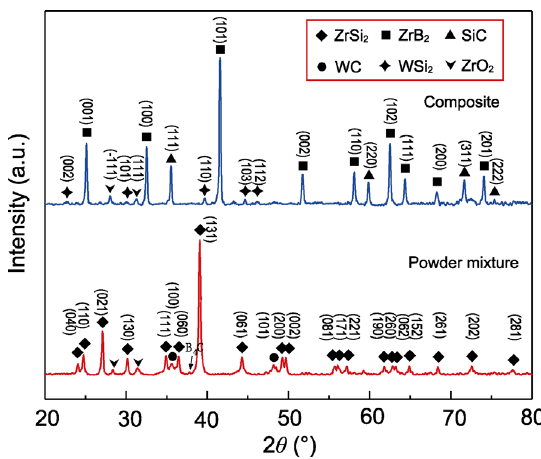
Fig. 1 XRD spectra of raw powder mixtures and the final composite for RZSZ-0.